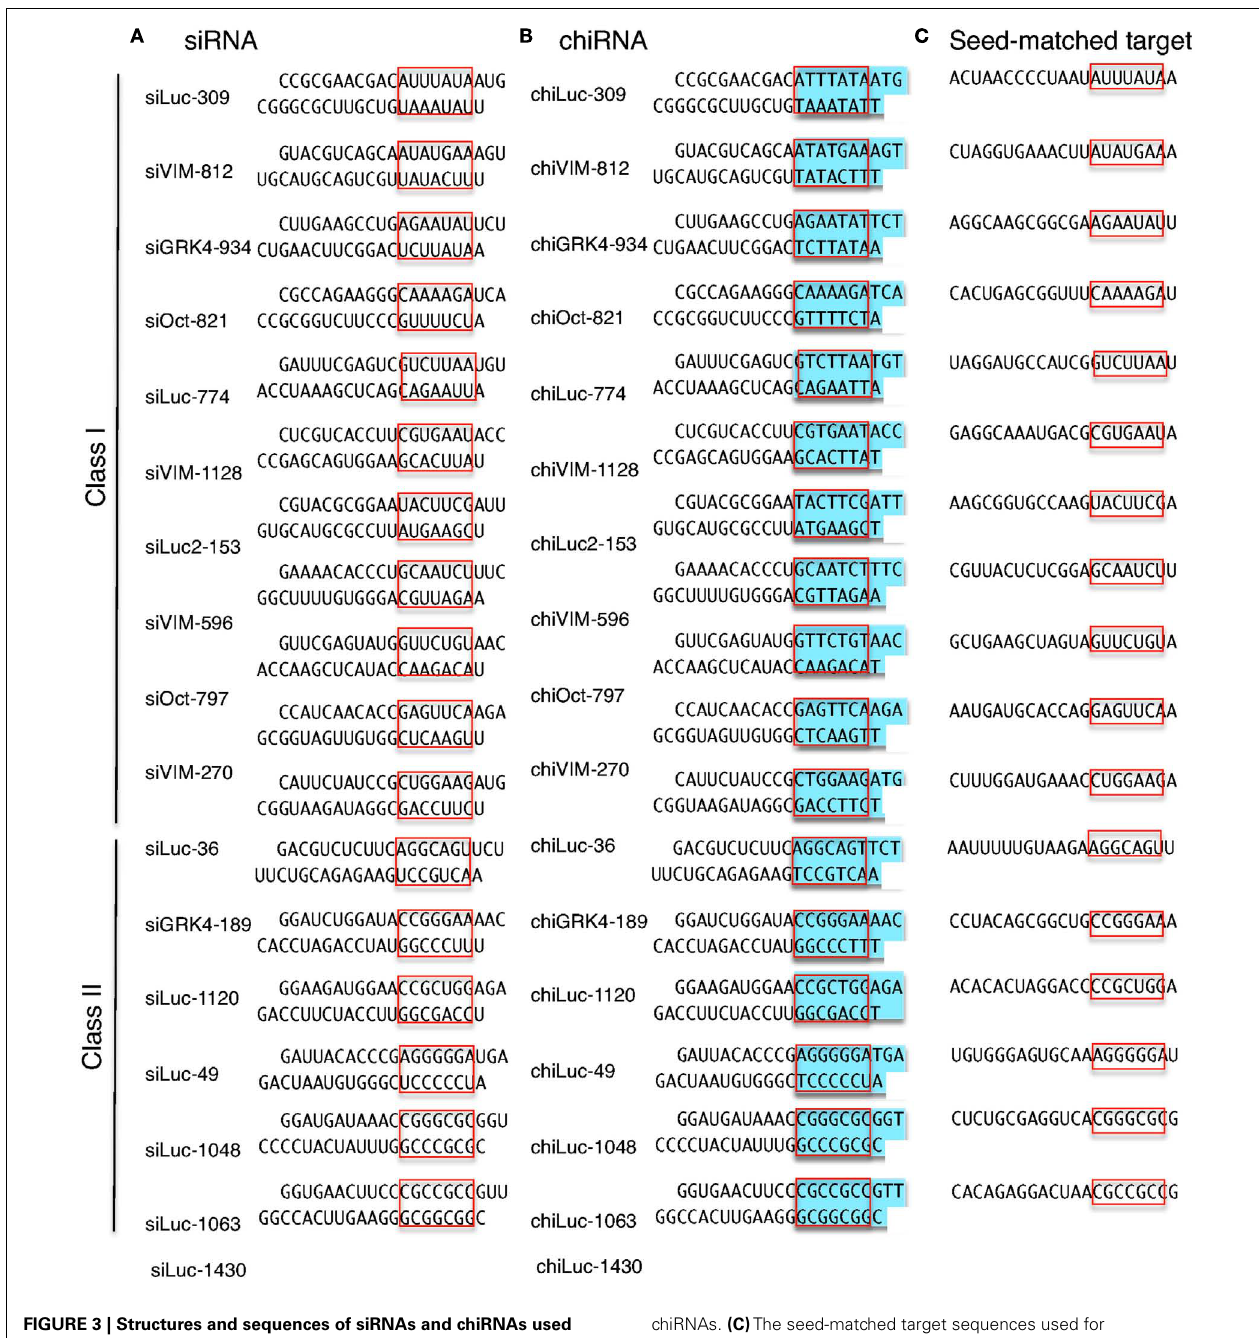
FIGURE 3 | Structures and sequences of siRNAs and chiRNAs used in this study and their seed-matched target sequences. (A) The structures of 11 human class I siRNAs and six class II siRNAs. (B) The structures of 11 human class I chiRNAs and six class II